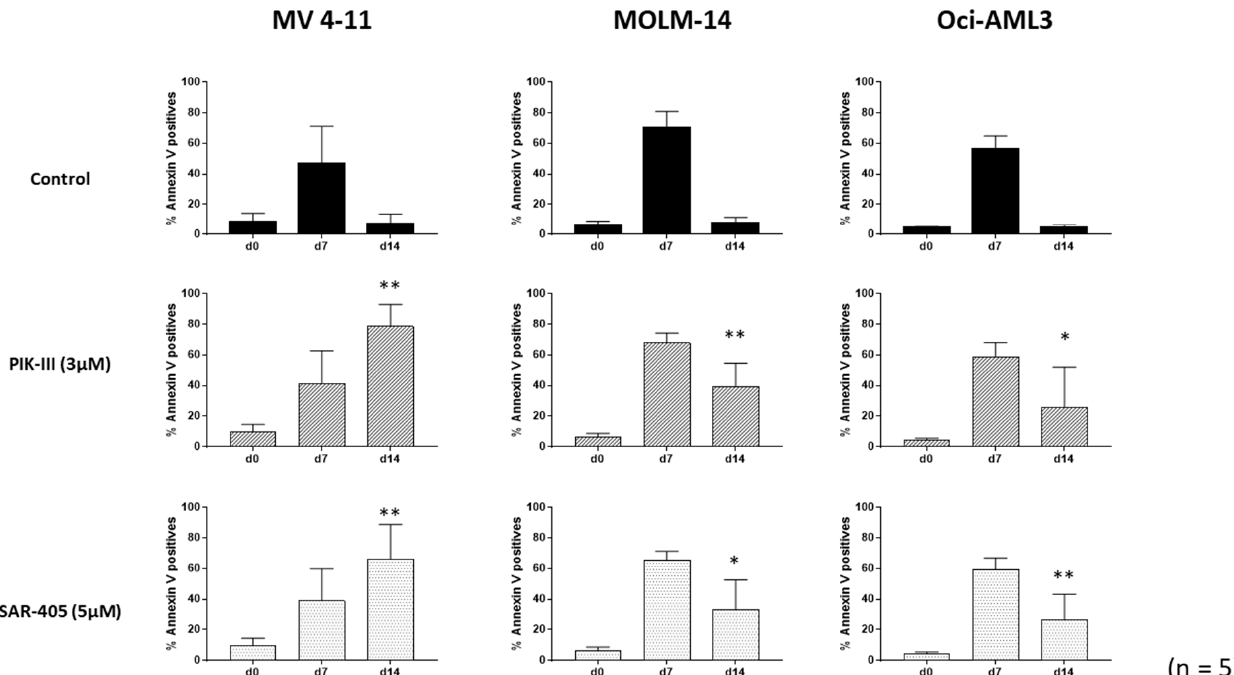
Figure 2. Inhibition of autophagy enhances apoptosis of FLT3-ITD AML cells. AML cell lines were placed at day 0 at 1% O 2 for 7 days. At day 7, cells were counted and apoptosis was quantified. Then, cells were treated or not and placed at 20% O 2 for the next 7 days. At indicated times (d 0 , d 7 and d 14 ), aliquots were analyzed by flow cytometry using annexin V-APC labeling. Results are from at least 5 experiments. Significance was quantitated using Wilcoxon test and is shown by an asterisk (* p < 0.05, ** p < 0.01).